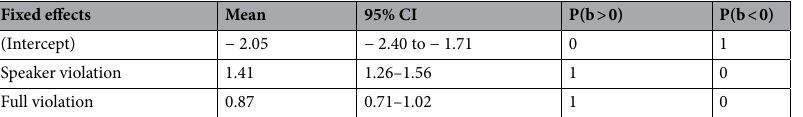
Table 3. Summary of Bayesian Logistic Linear Mixed Effects Model for Experiment 1 with congruent as the reference level. Mean represents the posterior mean unstandardized beta coefficient, 95% CI represents the credible interval around the mean, P(b > 0) represents the probability that the coefficient is greater than zero, and P(b < 0) represents the probability that the coefficient is less than zero.